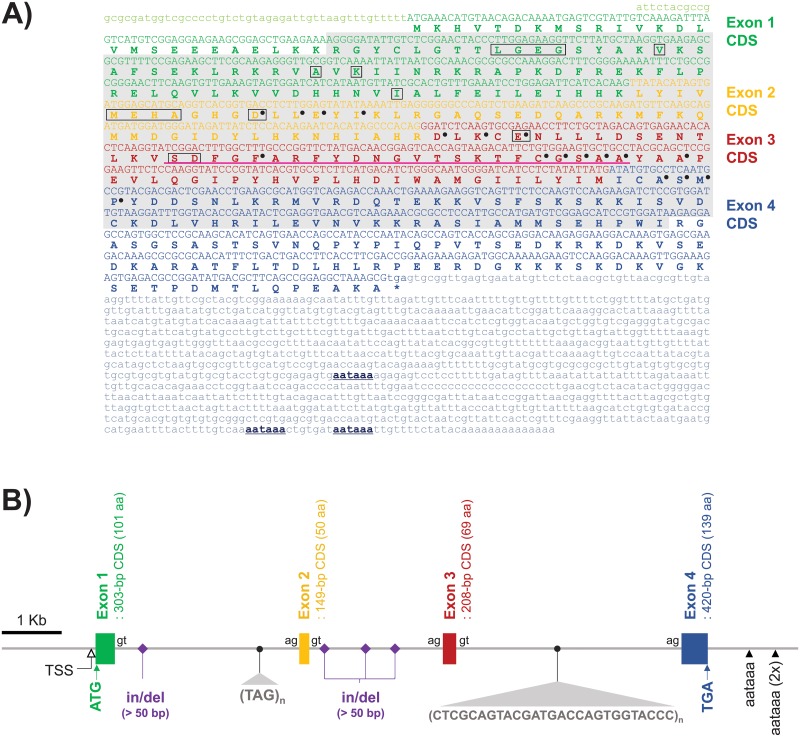
Full-length cDNA sequence and genomic organization of abalone Haliotis discus hannai TSSK1-like gene.(A) Coding sequence (CDS) and non-coding sequence of each exon (Exon 1–Exon 4) are indicated by uppercase and lowercase letters, respectively. Deduced amino acid sequence is noted by singlet code below the coding nucleotide sequence. Amino acid residues associated with putative ATP-binding are boxed, while residues for substrate binding are indicated with dots. Putative activation loop is underlined in exon 3. Conserved STKc catalytic domain is shaded grey. Putative polyadenylation signals (AATAAA) in 3´-non-translated region are bolded and underlined. (B) A tetrapartite exon-intron organization of abalone TSSK1-like. Major sites associated with intronic length polymorphisms are noted, including insertion/deletion (in/del) sites (in intron 1 and intron 2), tri-nucleotide (TAG)-repeats (a microsatellite in intron 1), and minisatellite region (in intron 3). Relative positions of transcription start site (TSS) and polyadenylation signals (AATAAA) are indicated. For details on polymorphisms, see S2 Fig.